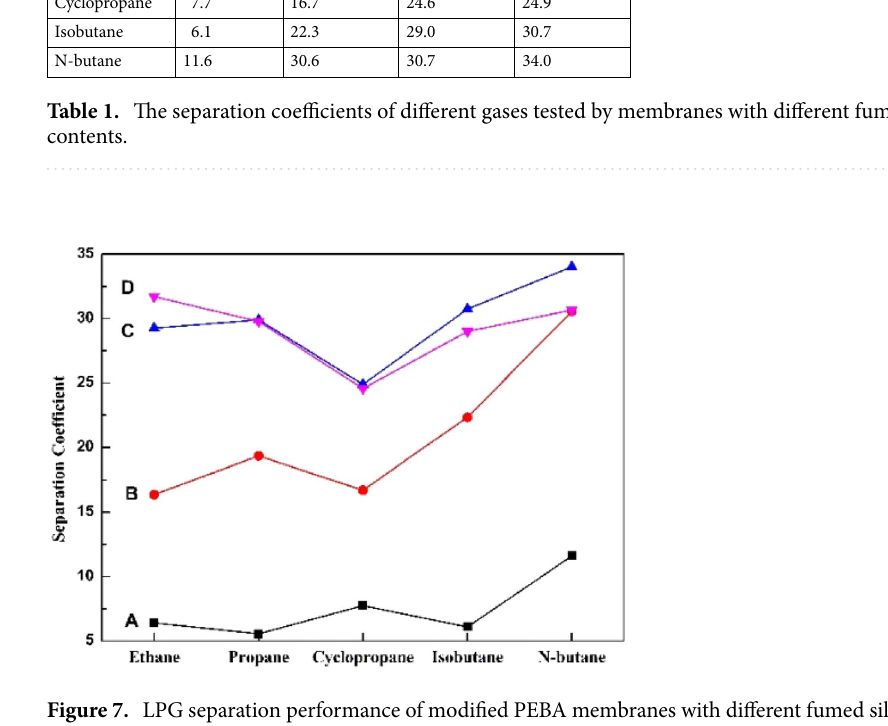
Figure 7. LPG separation performance of modified PEBA membranes with different fumed silica contents. (Lines A, B, C, and D correspond to PES/PEBA 0 , PES/PEBA 0.2 , PES/PEBA 0.6 and PES/PEBA 0.4 ,